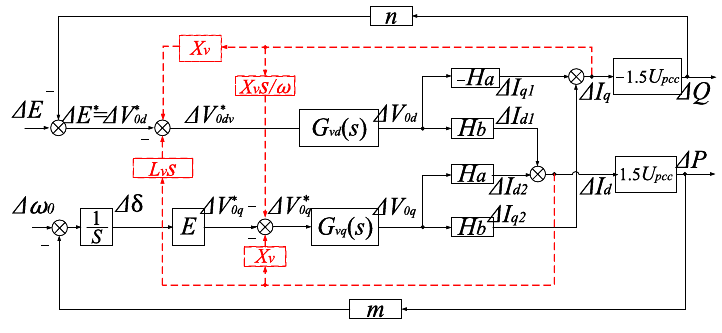
Figure 7. Droop control structure diagram in low-voltage MG.